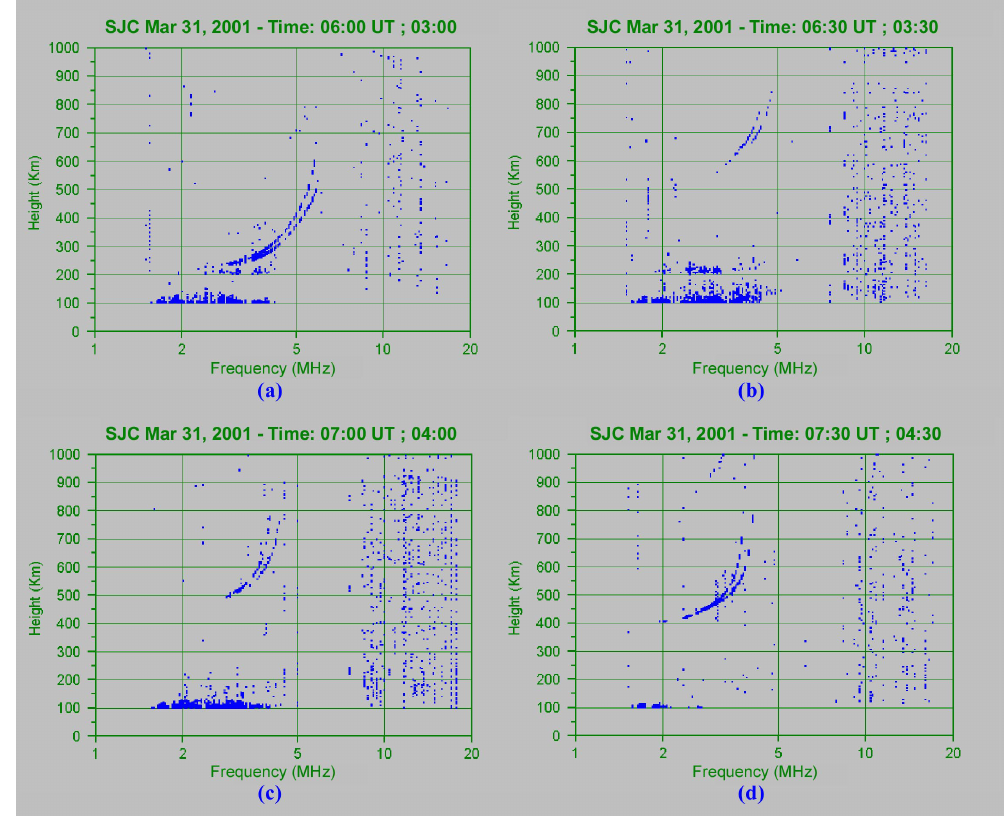
Figure 3 Fig. 3. Ionograms obtained at S˜ao Jos´e dos Campos between 06:00 and 07:30 UT (03:00–04:30 LT) on 31 March showing the presence